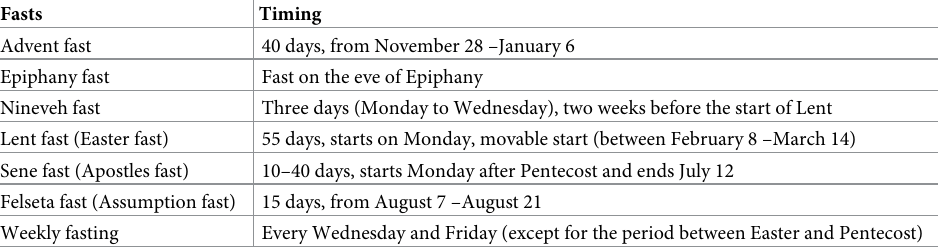
Table 1. Overview of the obligatory fasting events and feasts in Ethiopia according to the Orthodox Church doctrine.